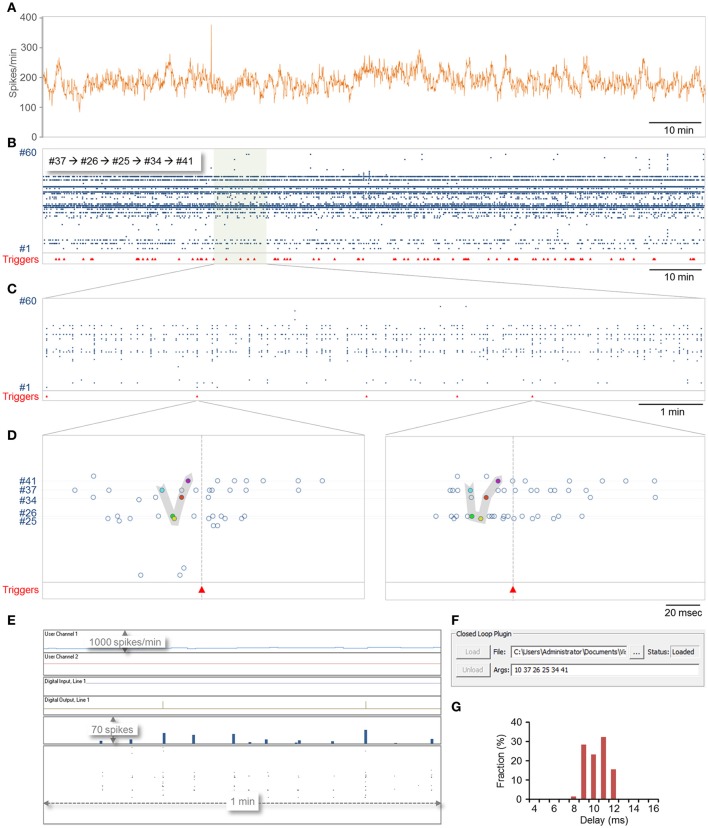
Demonstration of closed-loop plugin execution. CLEM was connected to a MEA amplifier recording from a network of cortical neurons plated on a 59 electrode MEA dish. A plugin containing both real-time and slow periodic closed-loop procedures was loaded, and run for 124 min. Sampling was carried out at 16 kHz per channel. (A) Spike rate, expressed in spikes per minute, calculated and logged on the fly by the slow-periodic closed loop procedure. This procedure was programmed to scan the spike history repository, count all spikes recorded from all electrodes within the last 1 min, and send the result to the display (User Channel 1 in (E). (B–F) Identification of predefined motifs by the real-time closed loop procedure. In this example, the motif was defined as five spikes recorded sequentially from electrodes 37,26,25,34, and 41, at time intervals of at most 10 ms. Motif identification was followed by the generation of a trigger signal on digital out line 1 and by enforcing a refractory period of 1 sec during which no triggers were to be issued. (B) Spikes recorded from all electrodes over this 2 h period. Red triangles at bottom show times at which triggers were issued. (C) A portion of the recording shown at higher magnification. (D) Two examples of motifs identified in the segment shown in (C). (E) A screenshot of CLEM's display during closed loop execution. Note the triggers issued on the digital out line and the output of the slow periodic closed-loop procedure to User Channel 1. (F) A screenshot showing how plugins are loaded and how arguments can be passed to them interactively. The ability to load and unload plugins allows the plugin to be modified without terminating CLEM. (G) The distribution of delays from last spike in the motif to the trigger. Note that delays were distributed more or less evenly across the duration of one closed-loop sample-analyze-output loop (~4 ms at a sampling rate of 16 kHz; see Figure 7A).